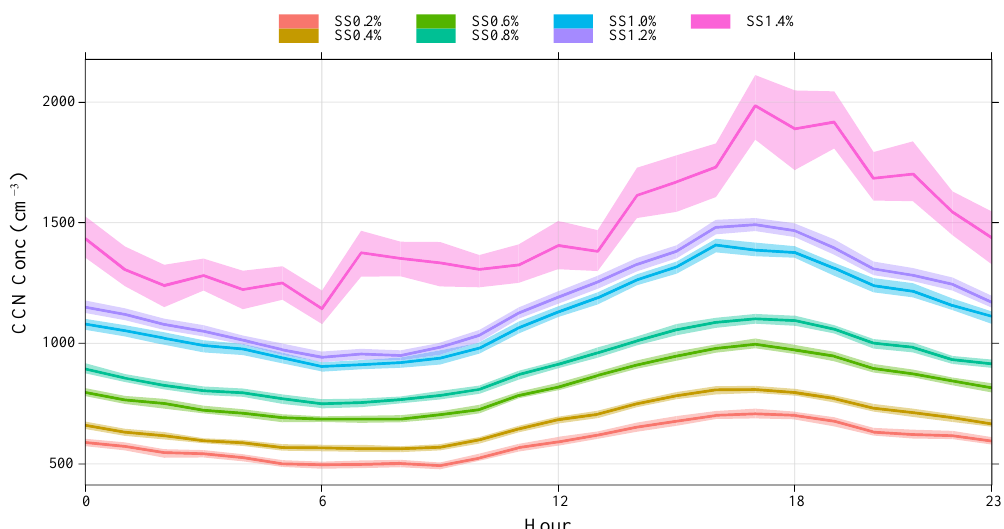
Figure 4. The diurnal variation in CCN in LPS.